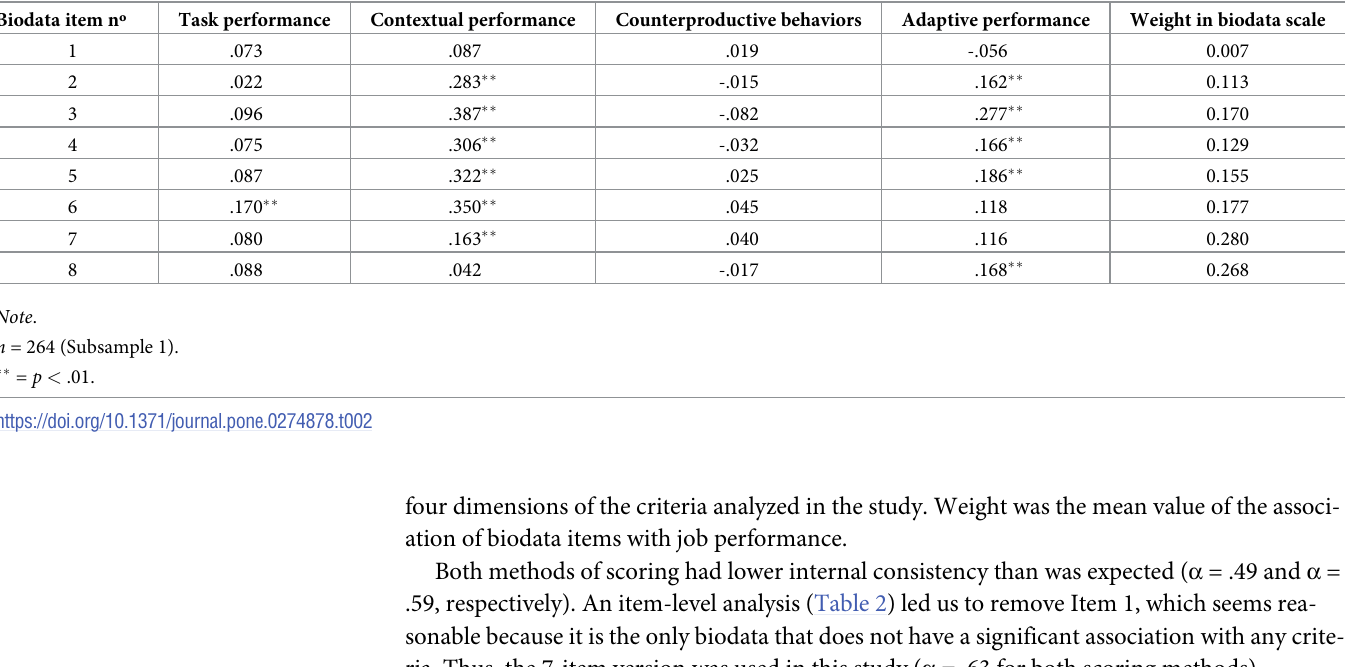
Table 2. Point-biserial associations between biodata items and